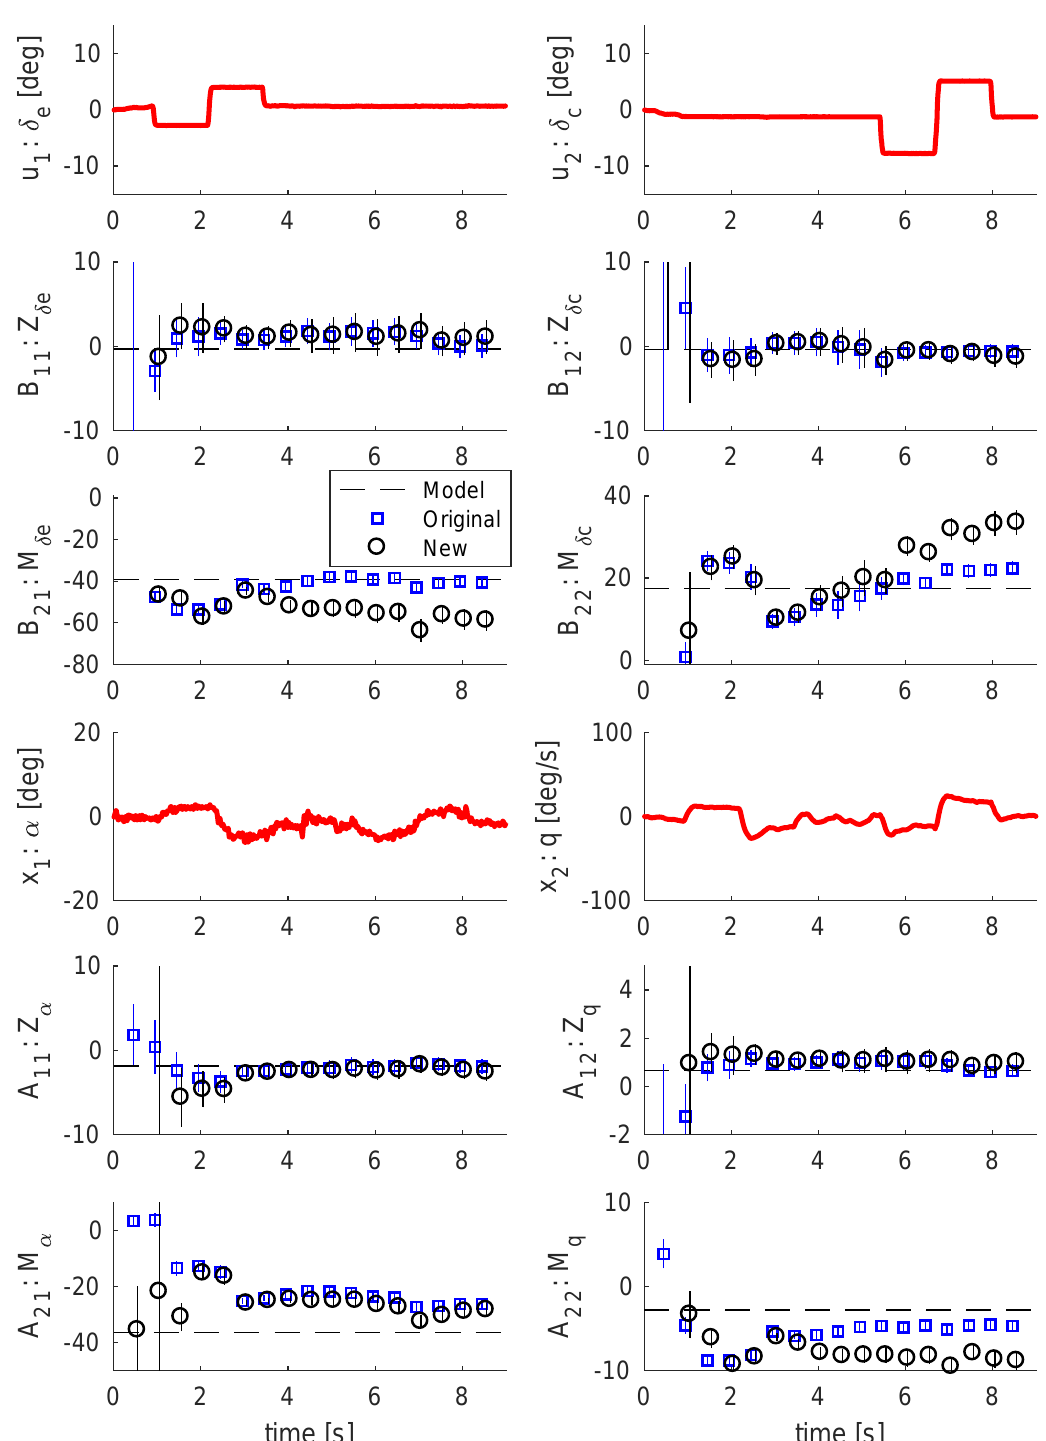
Figure 17. Results from flight FT. #3 with manoeuvre DPs2. The flight test data is shown in red, the results from the original method as blue squares and the results from the new method as black circles. The uncertainties are given as vertical bars. Note that the model (17) is not the true